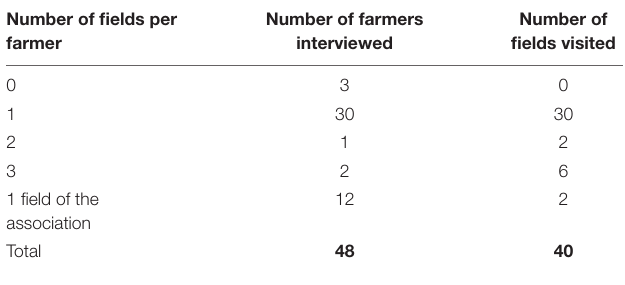
TABLE 1 | Farmers interviewed and fields visited in Villa López. Number of fields per